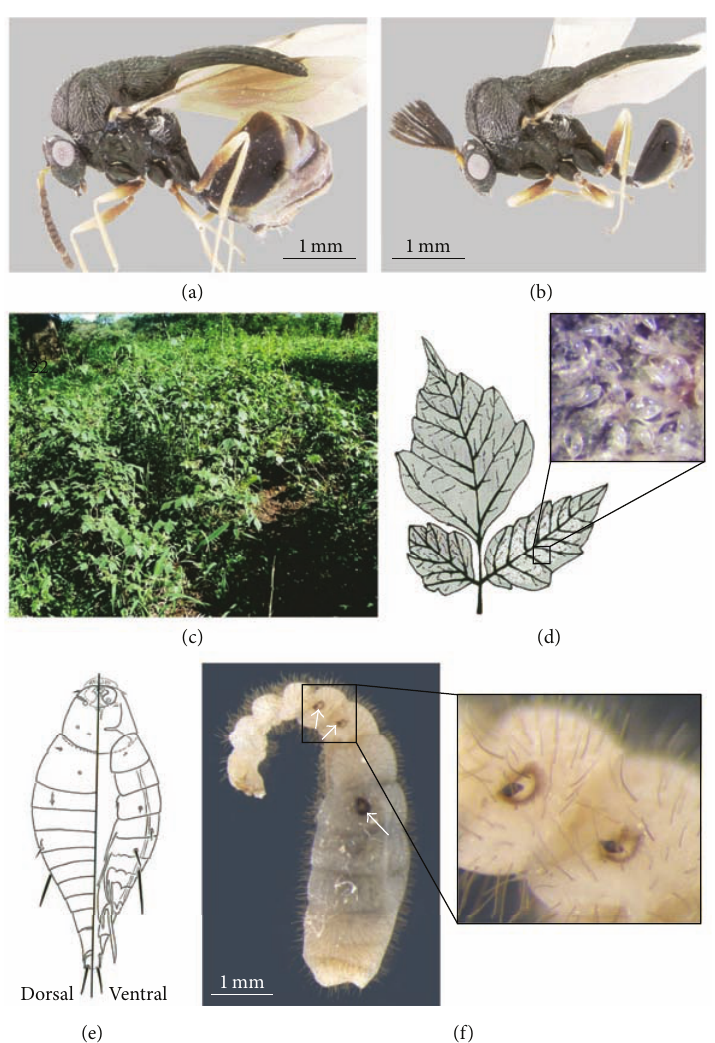
Figure 4: Latina rugosa : (a) habitus (female); (b) habitus (male). Biology and immature stage of L. rugosa : (c) habitat; (d) underside of leaf of Serjania glabrata with eggs (eggs represented in white area and magnified); (e) planidium (dorsal and ventral view); (f) ant larva parasitized (attached planidia magnified and indicated). Figures 4(d) and 4(e) are extracted from